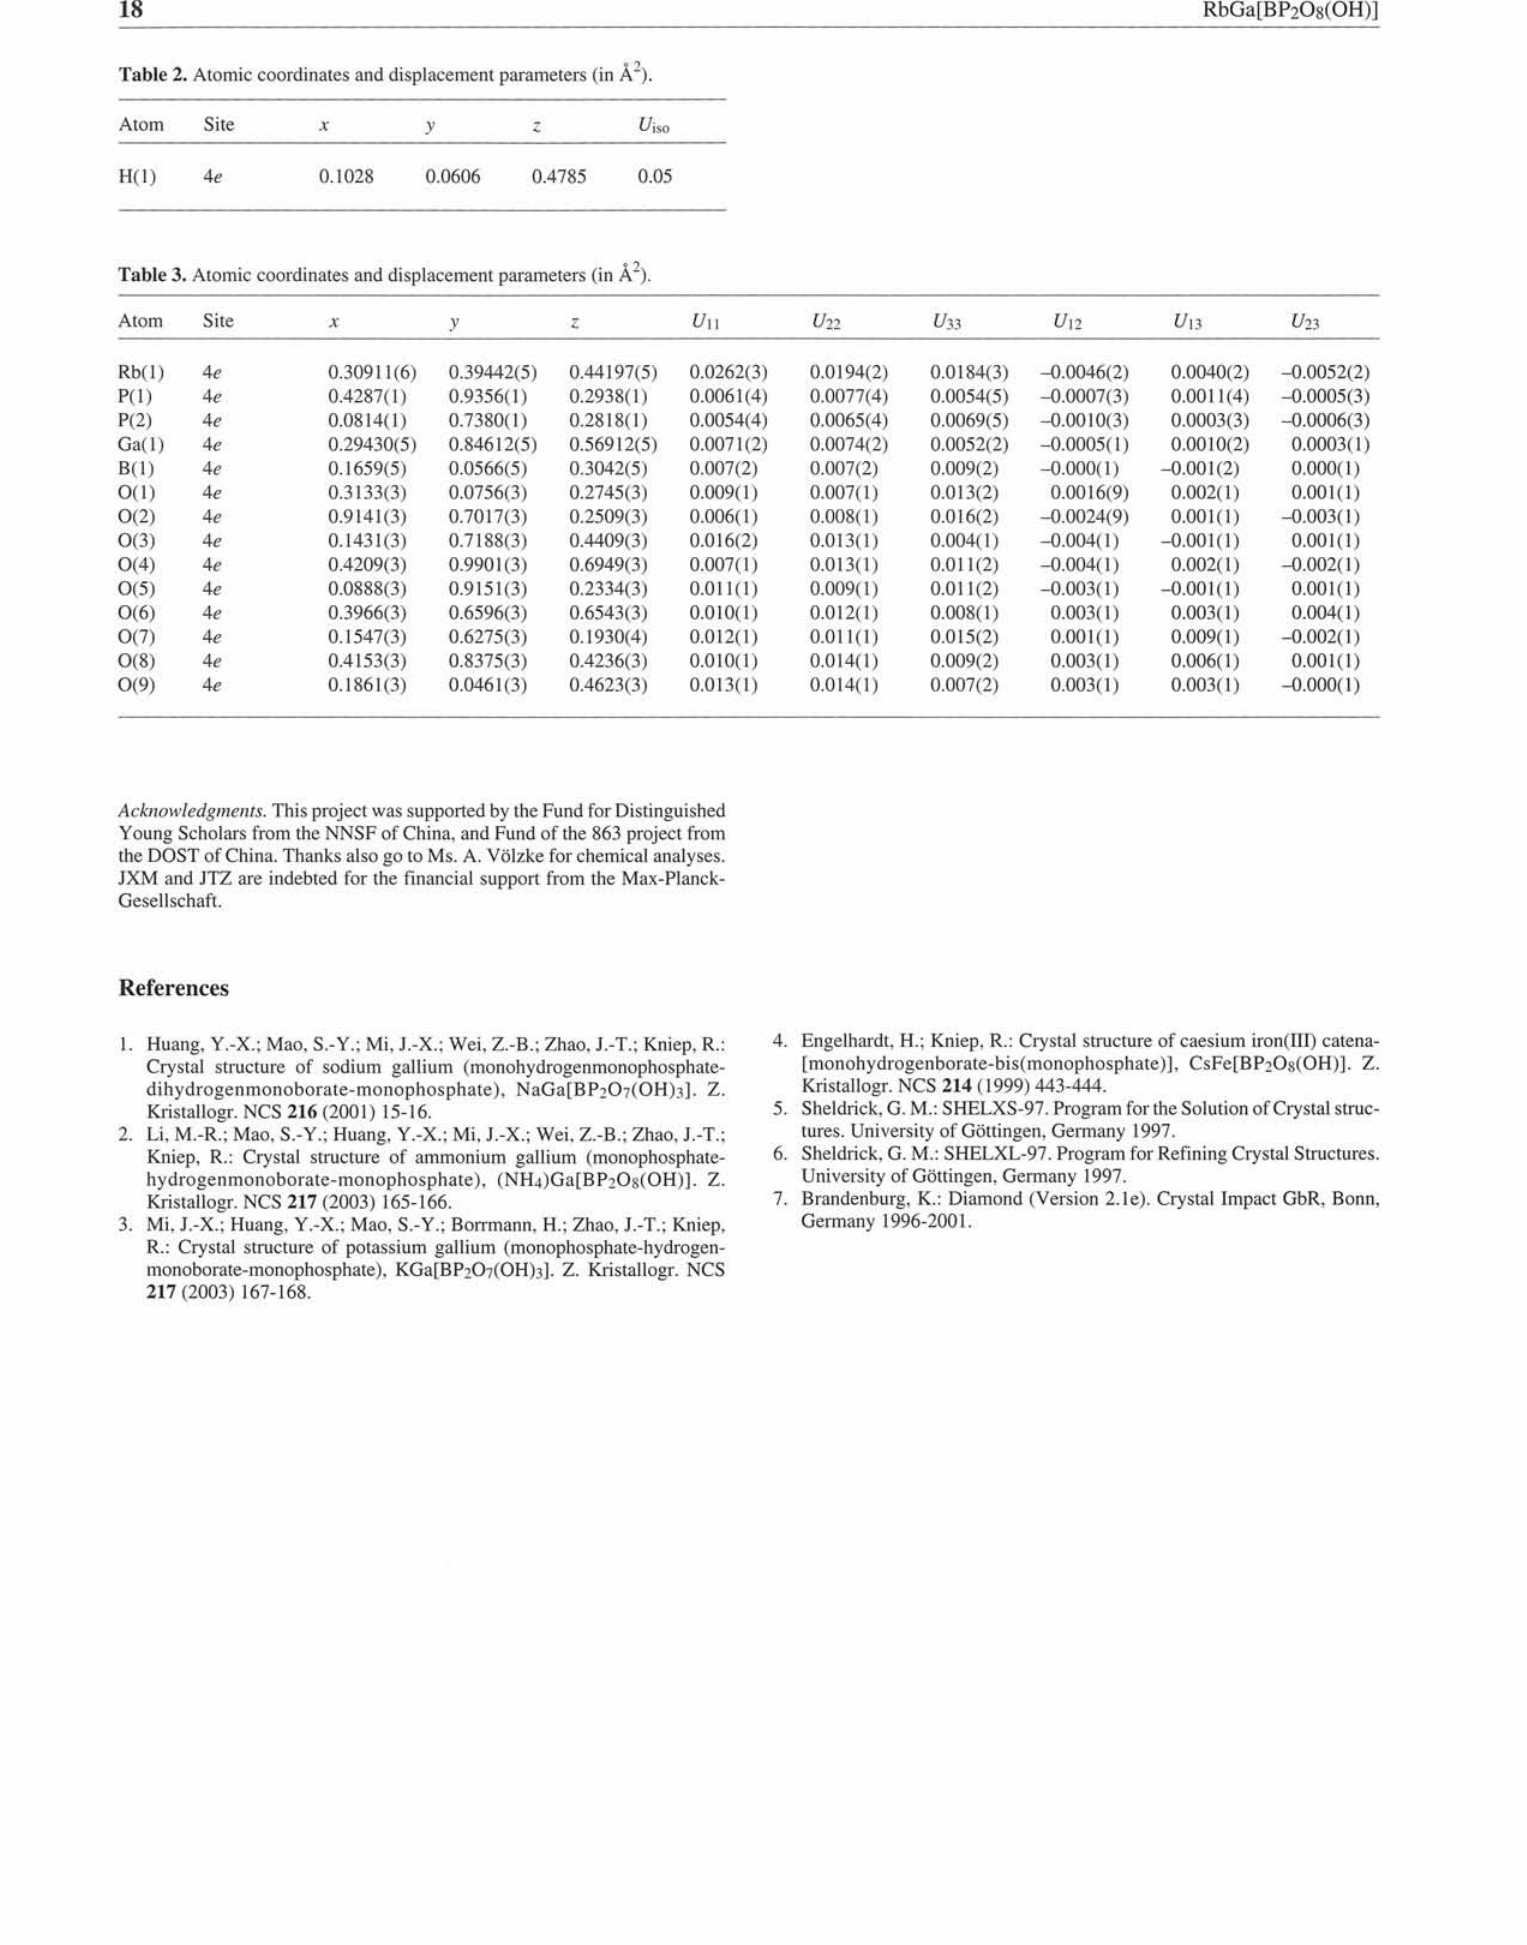
Table 2. Atomic coordinates and displacement parameters (in Â 2 ).